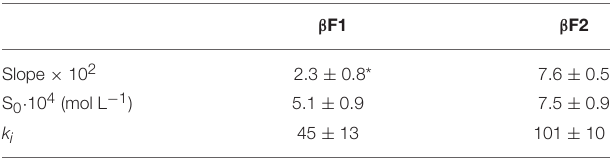
TABLE 2 | k i (inclusion constant) calculated from the A L -type phase-solubility diagram for β F1 and β F2 in β CD .